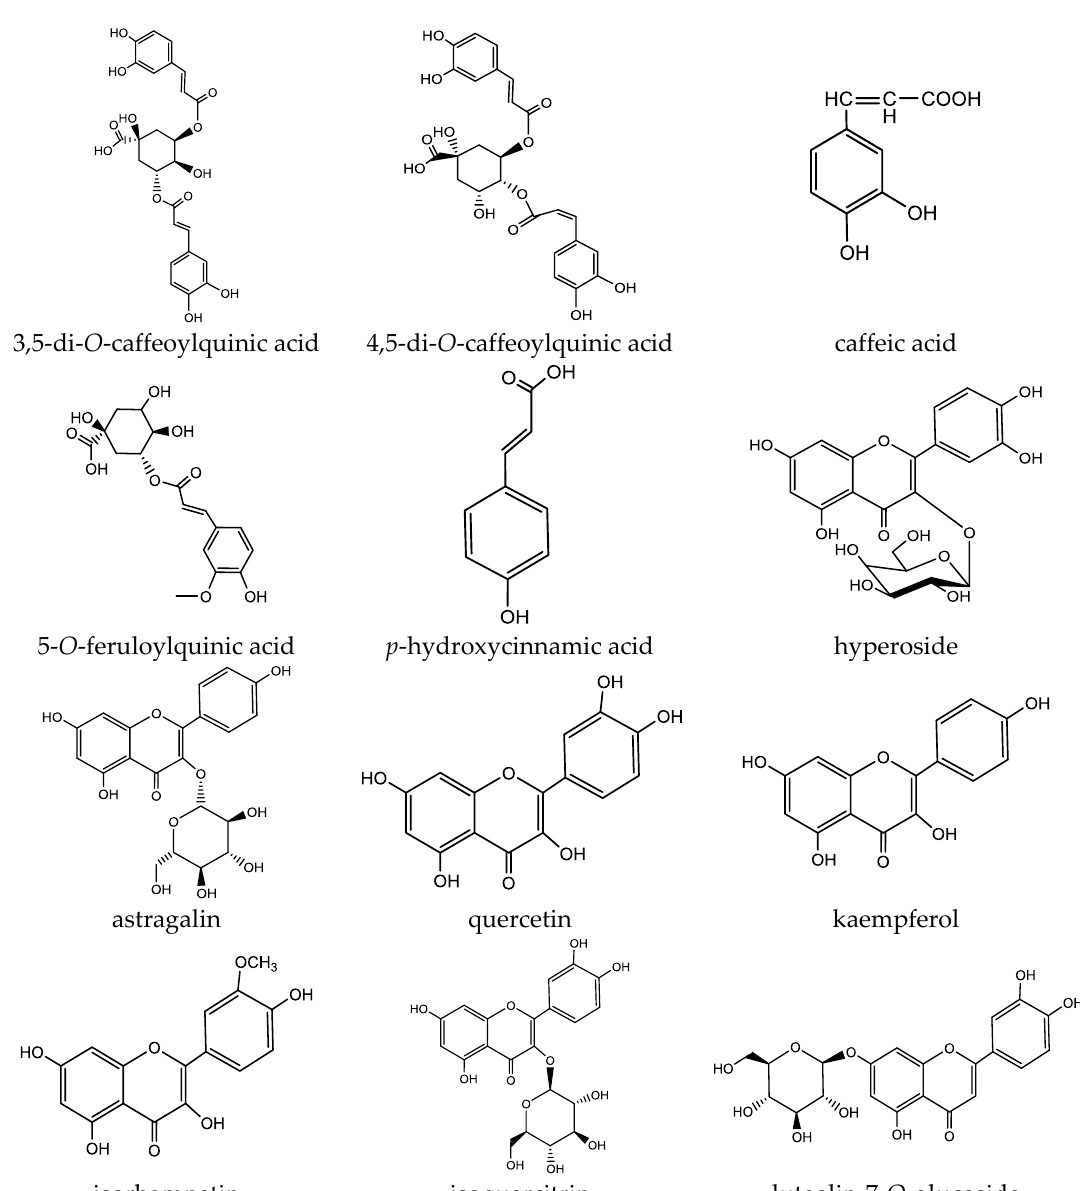
Figure 9. Chemical formula of flavonoids of Semen Cuscutae.